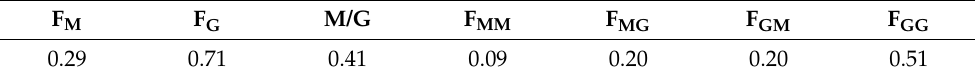
Table 1. The content of blocks G and M in the sodium alginate Protanal LF 10/60